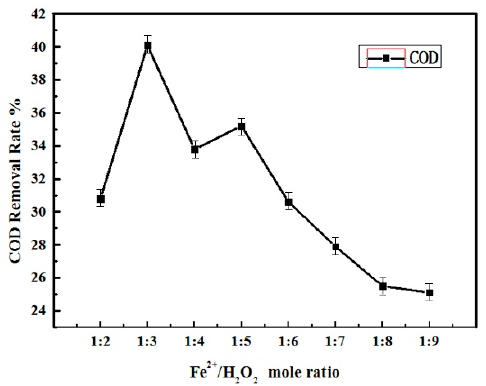
Figure 2. Chemical Oxygen Demand (COD) removal with Fe 2 + / H 2 O 2 mole ratio (pH = 1.9–2.2) (error = ± 5%).